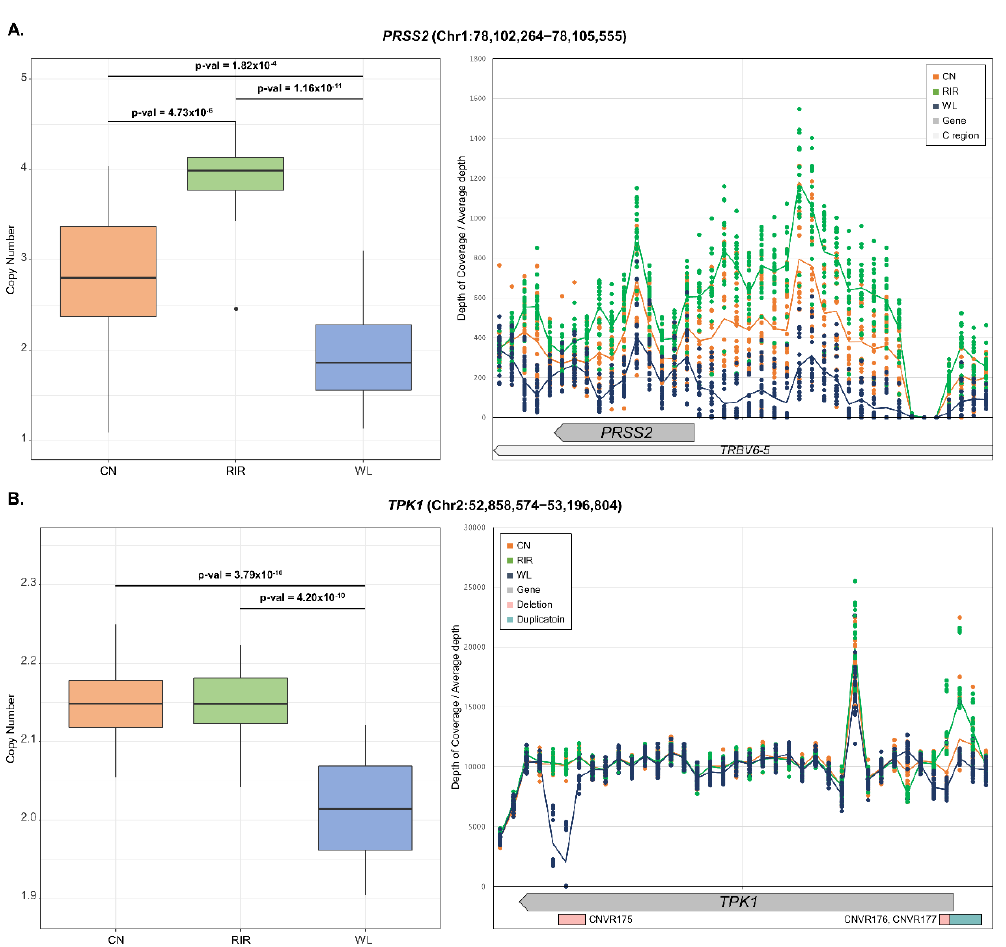
Figure 4. Estimated copy numbers of genes with different copy numbers between breeds and depth of coverage of gene region. The center line of the box represents the median and the line at the end of the box represents the first and third quartiles. Tukey’s HSD test was used to determine which breeds were significantly different (left). The depth of coverage of the region around the gene was extracted for a specific window size and divided by the total depth of each sequence file. The window size was determined by gene size. The scatter plot represents each individual and the line represents breed average (right). ( A ) PRSS2 , window size: 300bp; ( B ) TPK1 , window size: 10,000bp.